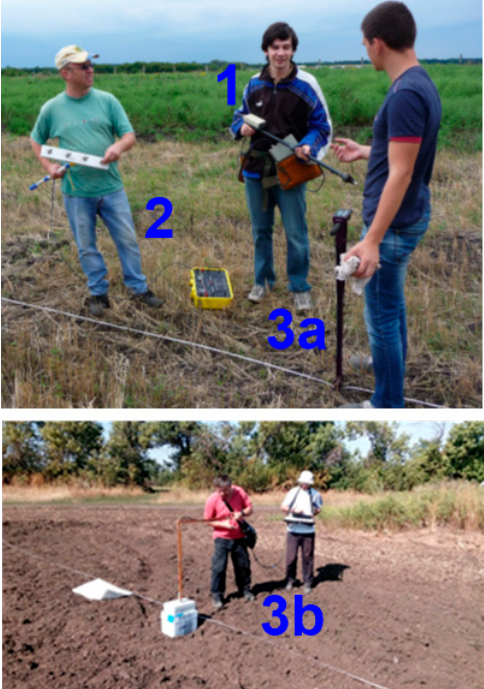
Figure 3. Photographs of field equipment. (1) Bartington MS2 magnetic susceptibility meter with MS2F probe, (2) L&R Instruments MiniRes with 4-electrode probe. (3a) Spectrum Technologies Field Scout 300 TDR. (3b) Purpose-built 1-Tx, 2-Rx impulse